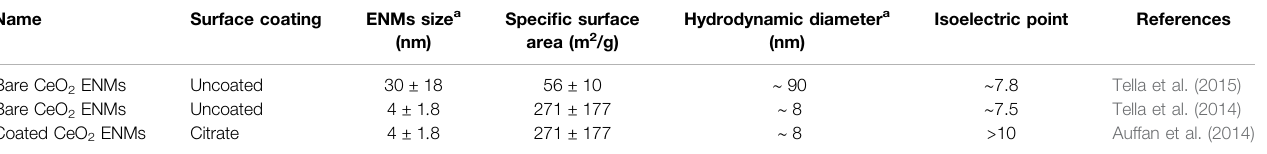
TABLE 1 | Main physicochemical characteristics of CeO 2 ENMs used to contaminate the